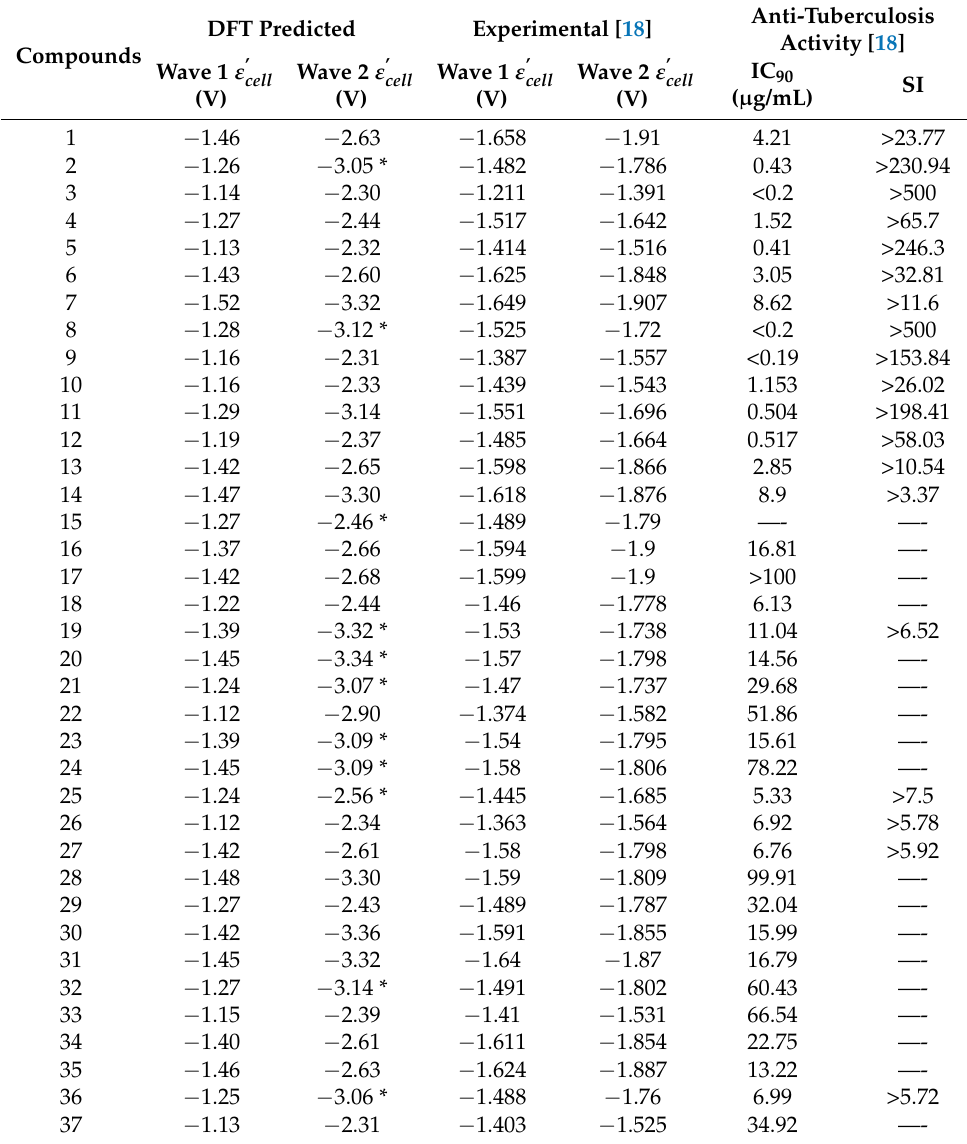
Table 3. The DFT: B3LYP/lanl2dz-predicted electrochemical potential, experimental [18] electro- chemical cell potentials, and anti-tuberculosis activities [18] for the 1,4-di-N-oxide quinoxaline-2- carboxamide